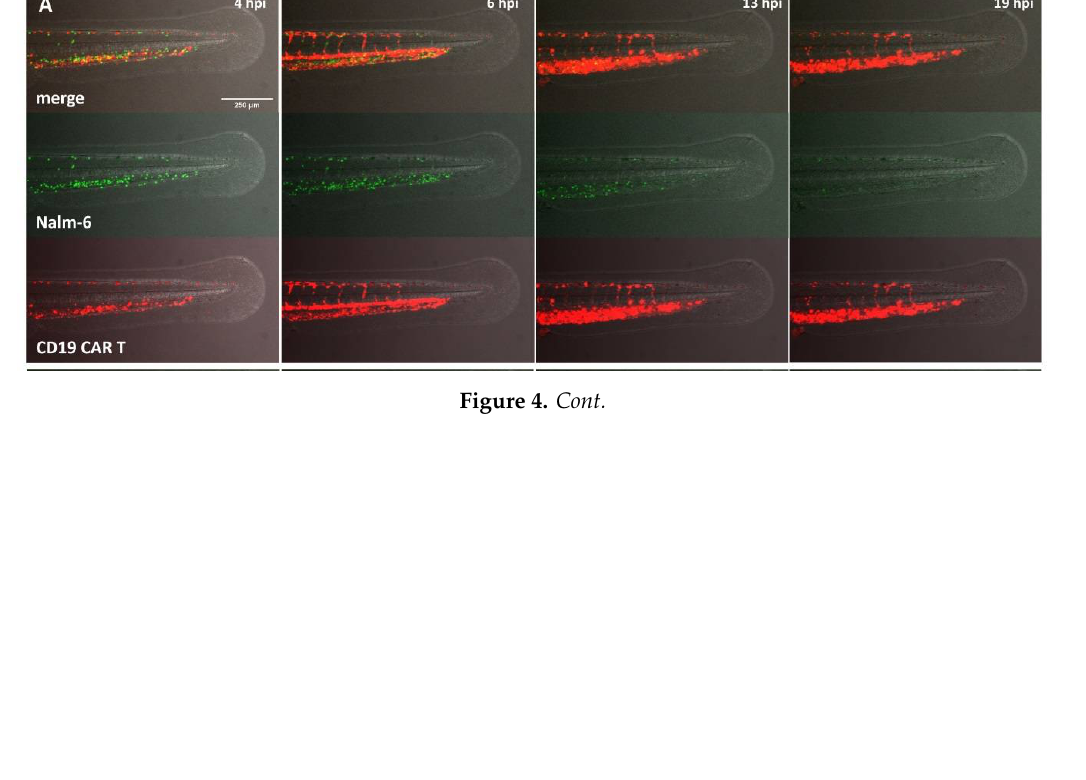
Figure 4. Quantifying specific elimination of Nalm-6 cells over time. Zebrafish embryos were injected with Nalm-6 cells (green) at approximately 48 hpf. Around 2 hours later, either CD19 CAR T cells (red cells in ( A )) or T cells without a CAR (red cells in ( B )) were injected and a time-lapse movie was recorded, starting approximately 4 hours post injection of T cells. Several time points of one embryo co-injected with CD19 CAR T cells ( A ) or mock T cells ( B ) are shown as single frames. ( C ) Quantification of cells over time based on the fluorescent area using Fiji. Nalm-6 (blue dots) in the presence of CD19 CAR T cells (shown as green dots), or the presence of T cells without CAR ( D ). ( E ) Nalm-6 in the presence of CD19 CAR T cells (blue) and T cells without CAR (green) over time. Images were recorded on a Leica SP8 X WLL confocal microscope and rendered with Adobe Photoshop CS6. Scale bar in ( A ) represents 250 µm.